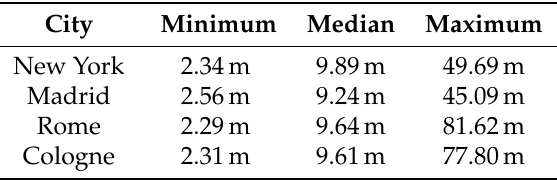
Table 3. Statistics of the widest diagonal at junctions in several